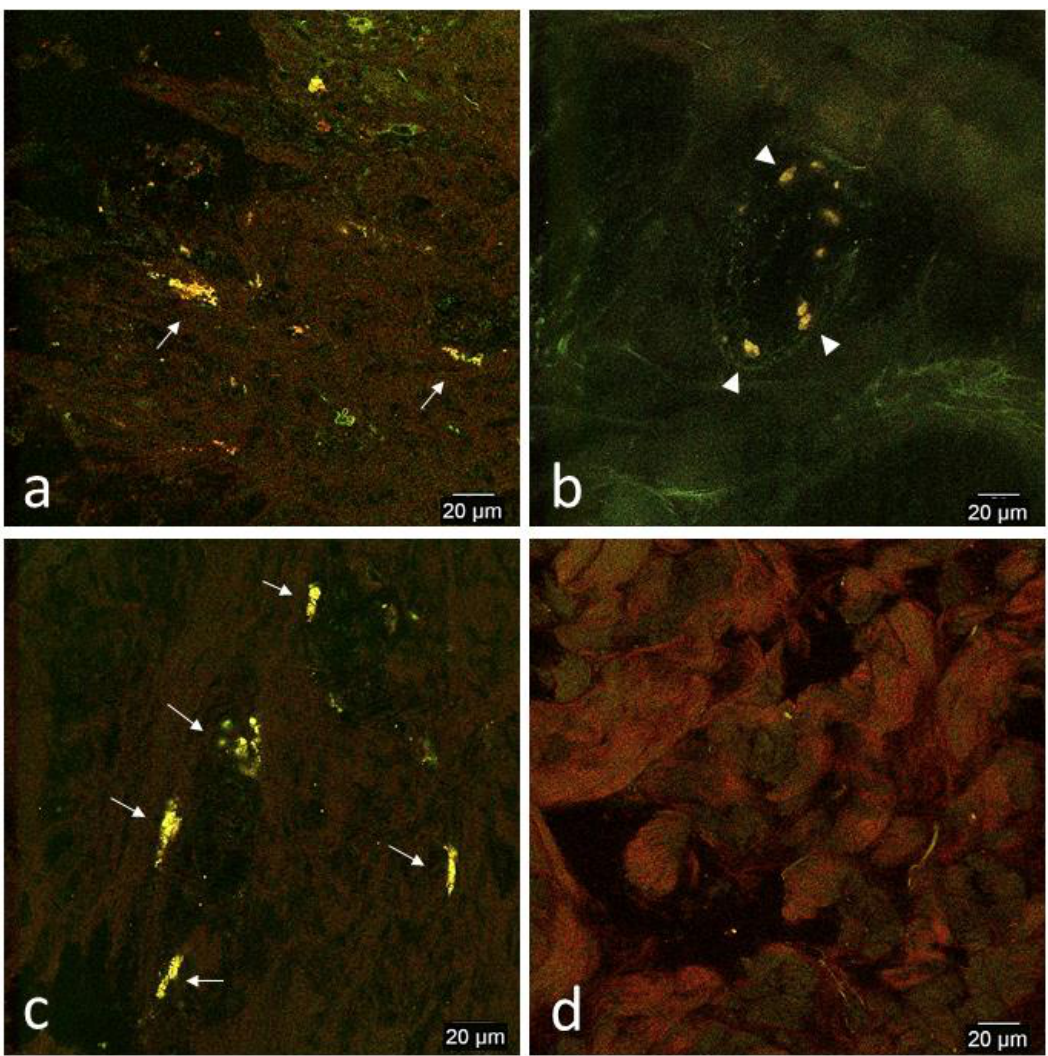
Figure 8. Representative confocal microscopy images of biopsies of limb and thoracic wounds and contralateral non-wounded skin on day 33. ( a ) Wounded limb, ( b ) non-wounded limb, ( c ) wounded thorax, and ( d ) non-wounded thorax. Images were selected from either horse based on best representation of patterns typical fluorescent signal patterns of both horses. Images have been selectively enhanced for purposes of demonstrating signal variation. In both horses, homing was marked in both limb and thoracic wounds and was characterized by cell-like structures consistent with in vitro CB-MSCs that appeared to be well integrated into the interstitium (arrows, a , c ). In contrast, cell-like structures were only rarely detected in the non-wounded side and were rounded, located primarily in the vasculature, and were smaller than those typically detected in the wounded biopsies (arrowheads, b ). Background auto-fluorescence was common in non-wounded biopsies and is shown in ( d ).